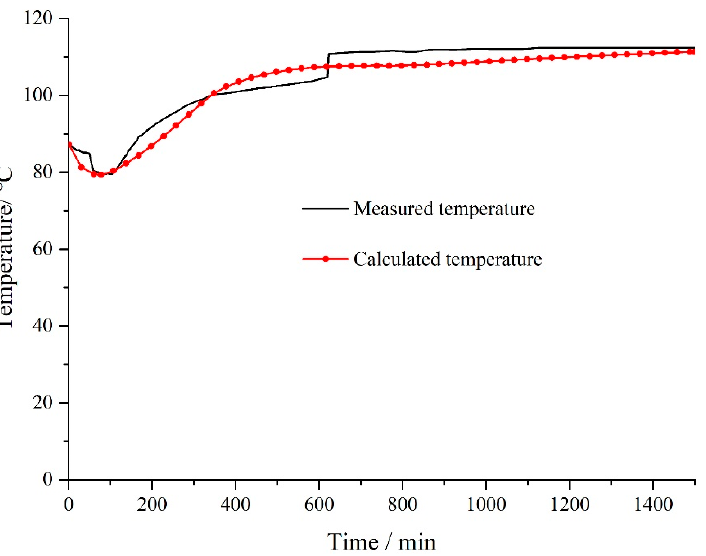
Figure 4. Calculation results of transient temperature at a well bottom during well construction.